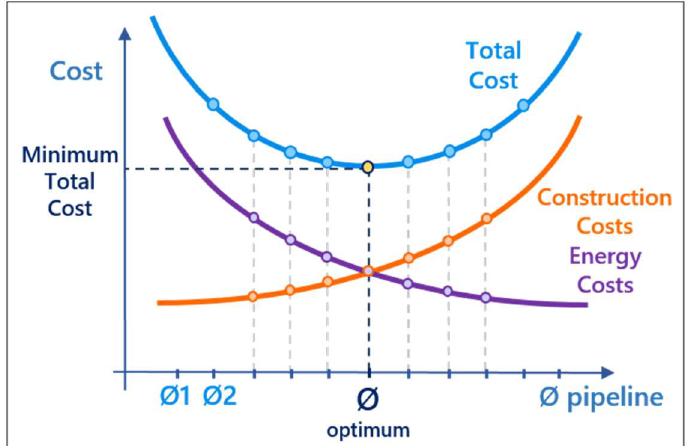
Figure 1. Simplified scheme of the costs of the water drive depending on the diameter ∅ of the pipeline: As the diameter increases the construction costs rise but the head losses decrease, implying a reduction in the energy cost.